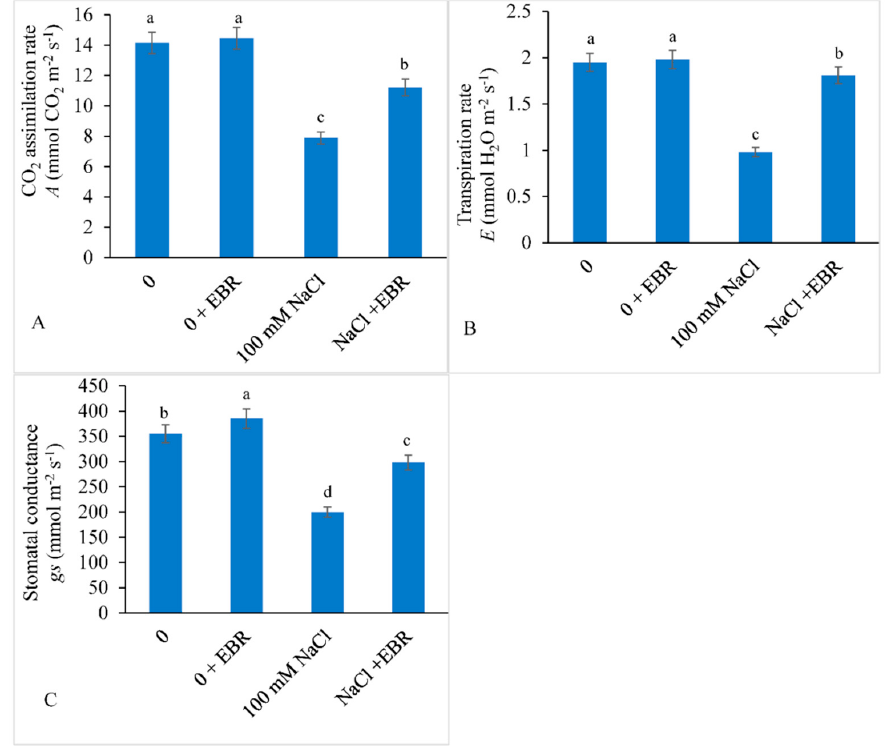
Figure 3. E ff ect of exogenously applied 24-epibrassinolide (EBR) on ( A ) CO 2 assimilation rate ( A ), ( B ) transpiration rate ( E ), and ( C ) stomatal conductance ( g s ) in soybean under NaCl toxicity. Data presented are the means ± SE ( n = 5) and significant di ff erence between the means calculated at p ≤ 0.05 using Duncan’s multiple range